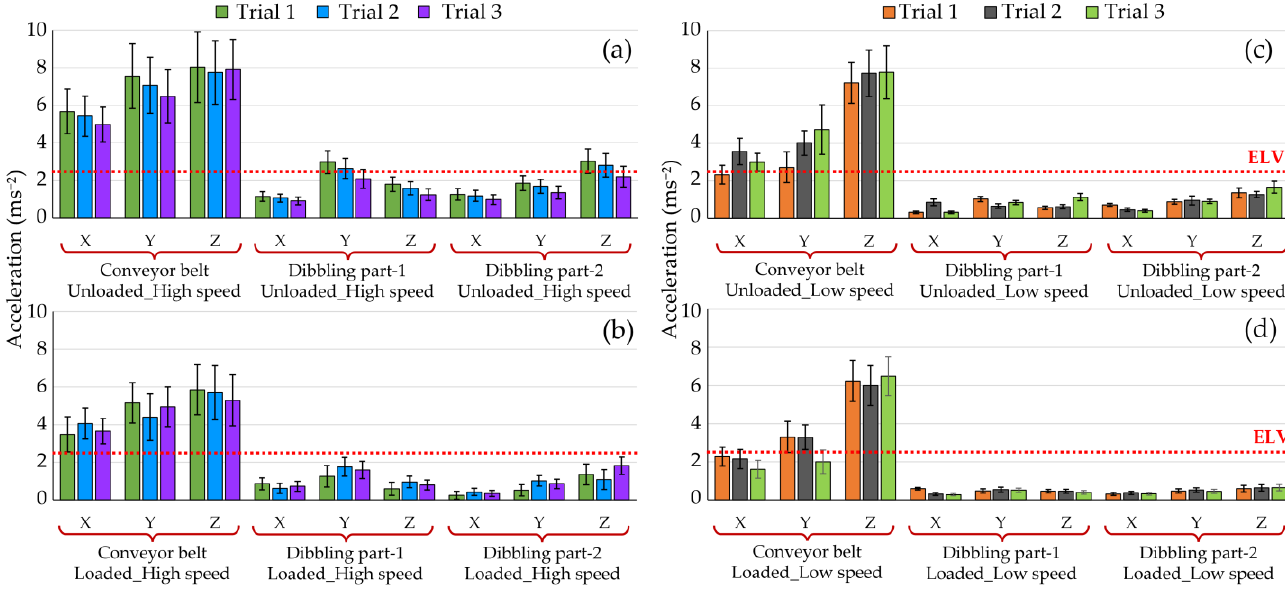
Figure 4. Vibrational exposures of the conveyor belt, dibbling part-1, and dibbling part-2 for different load conditions under high ( a , b ) and low ( c , d ) driving speeds during transplanting. The considered ELV was 2.5 ms −2 .